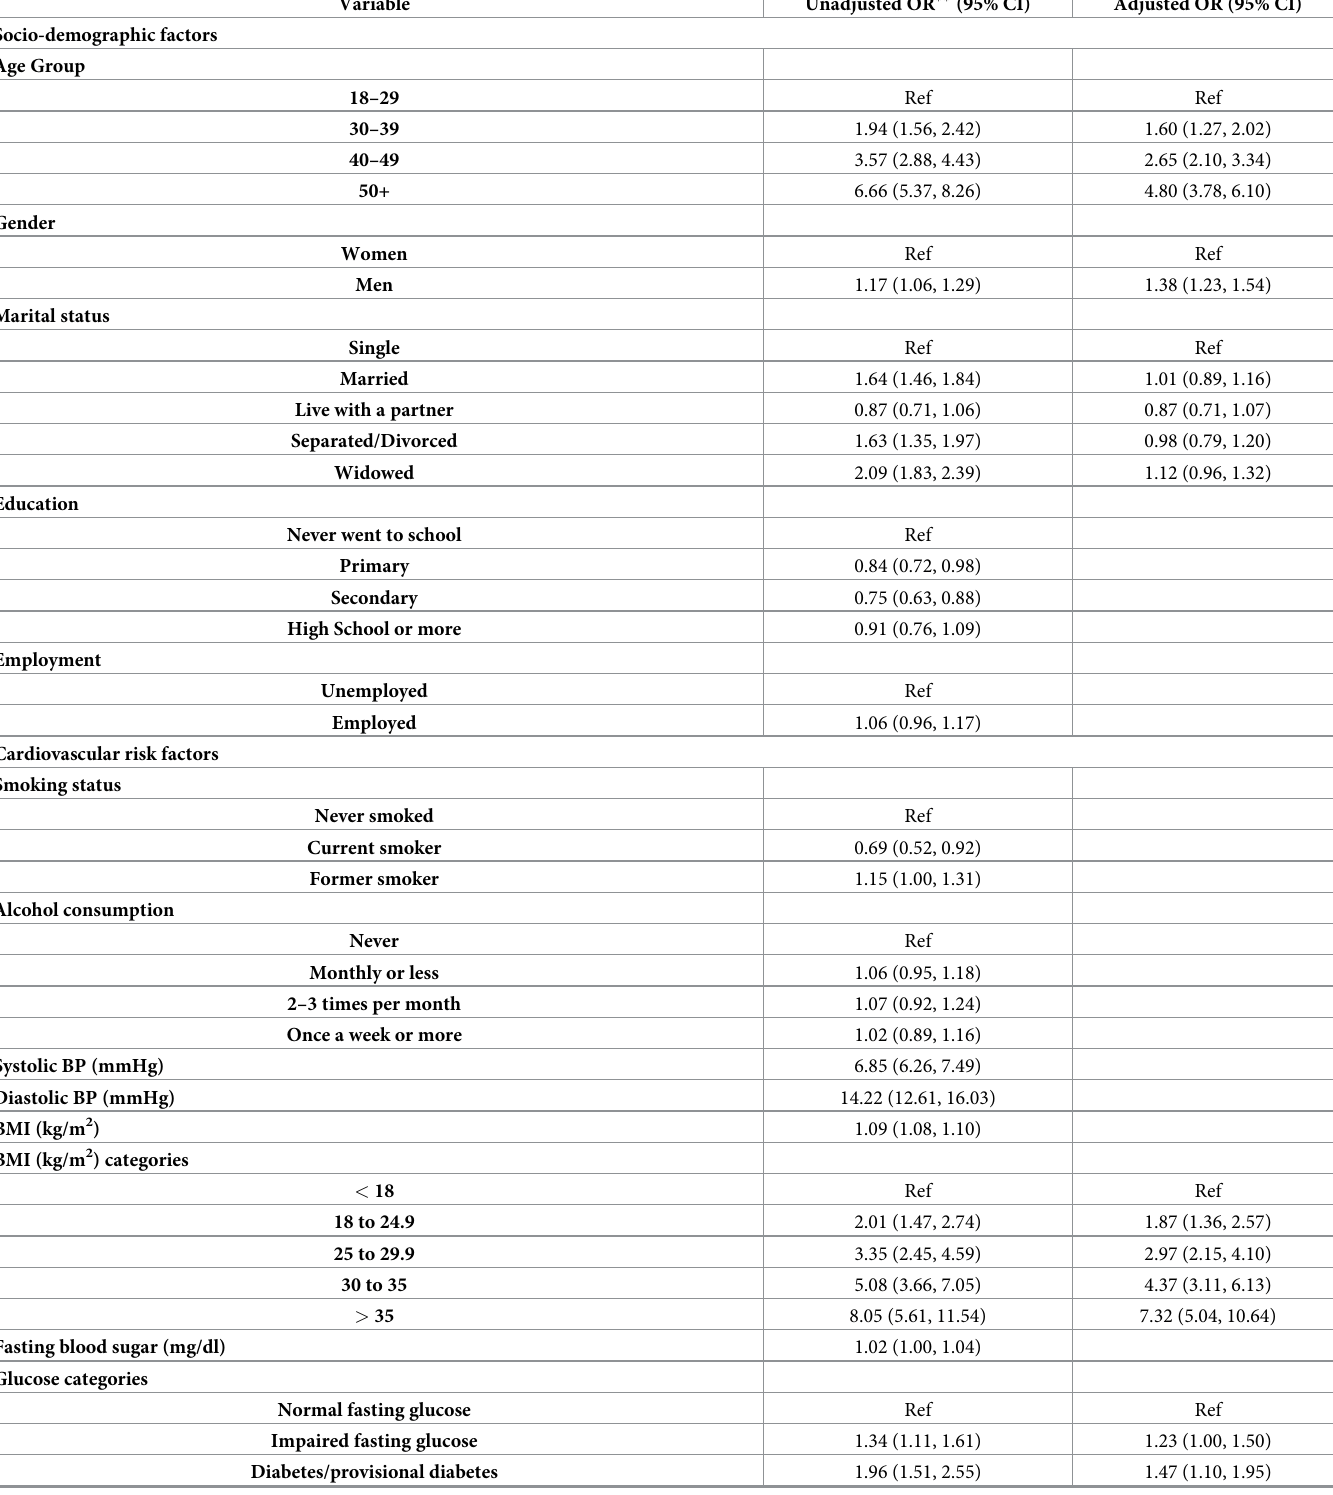
Table 2. Predictors of prevalent